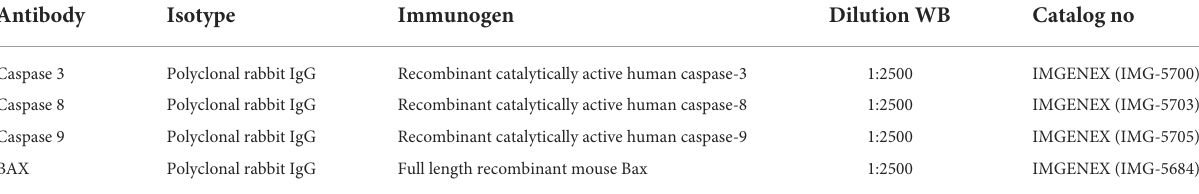
TABLE 2 List of antibodies for immunohistochemistry and western blotting (WB).